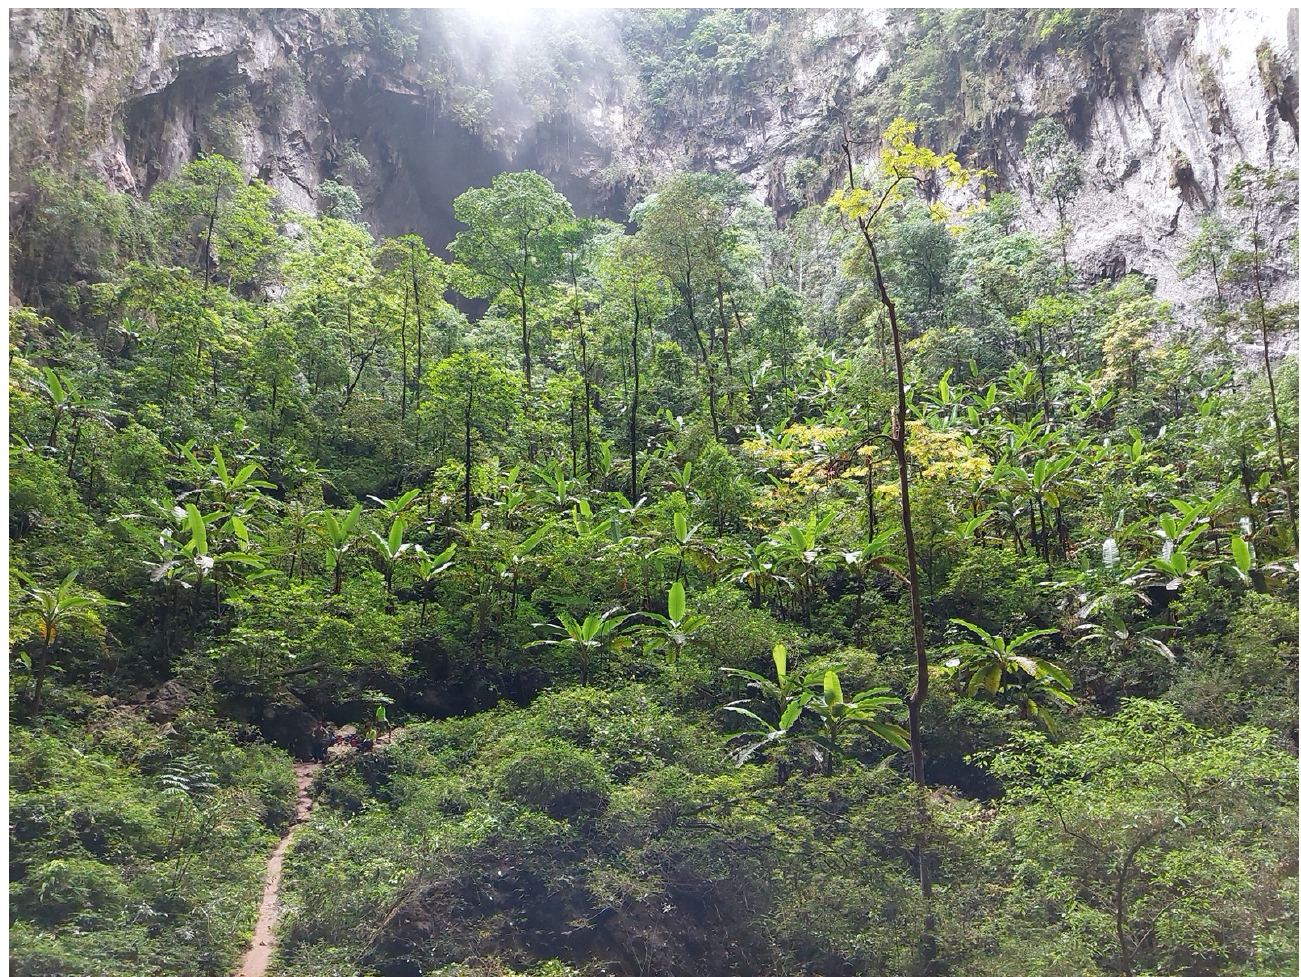
Figure 9. Primary forest in doline 2 of Son Doong Cave. Photo: Vu Dinh Thong .